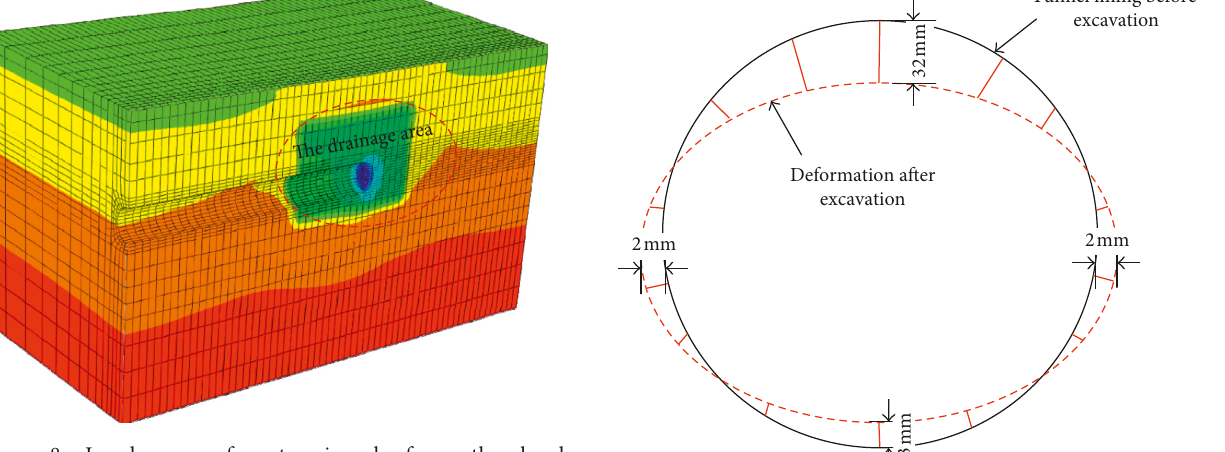
Figure 8: Local area of water inrush from the local excavation face.